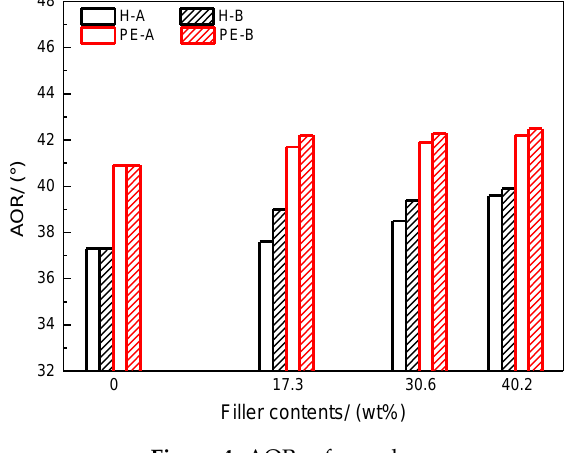
Figure 4. AORs of samples.